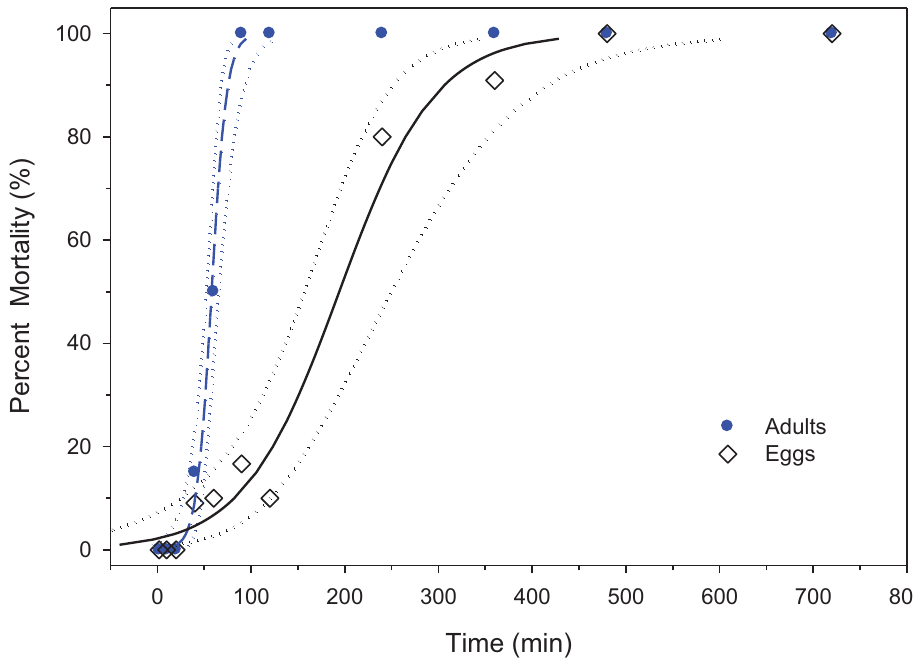
Figure 4. Mortality of bed bug adults ( (cid:2) ) and eggs ( (cid:2) ) when exposed to 45 °C after a temperature ramp of 0.06 °C/min. Logistic regression for adults (- - - ) and eggs (──) are displayed along with 95% CI ( (cid:3)(cid:3)(cid:3)(cid:3) and (cid:3)(cid:3)(cid:3)(cid:3) ). Regression characteristics were y = 0.125 Log (x) − 7.25 for adults and y = 0.0196 Log (x) − 3.80 for 10 10